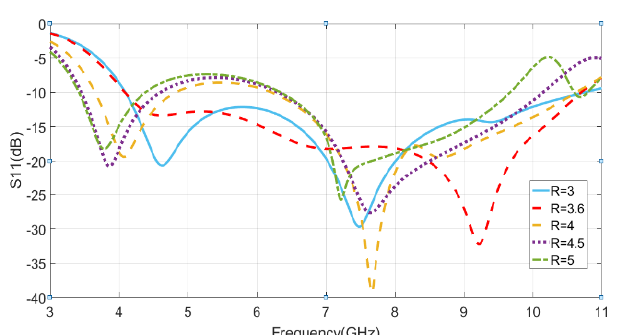
Figure8: The simulated S11 of the proposed antenna with c=1pf using CST and HFSS